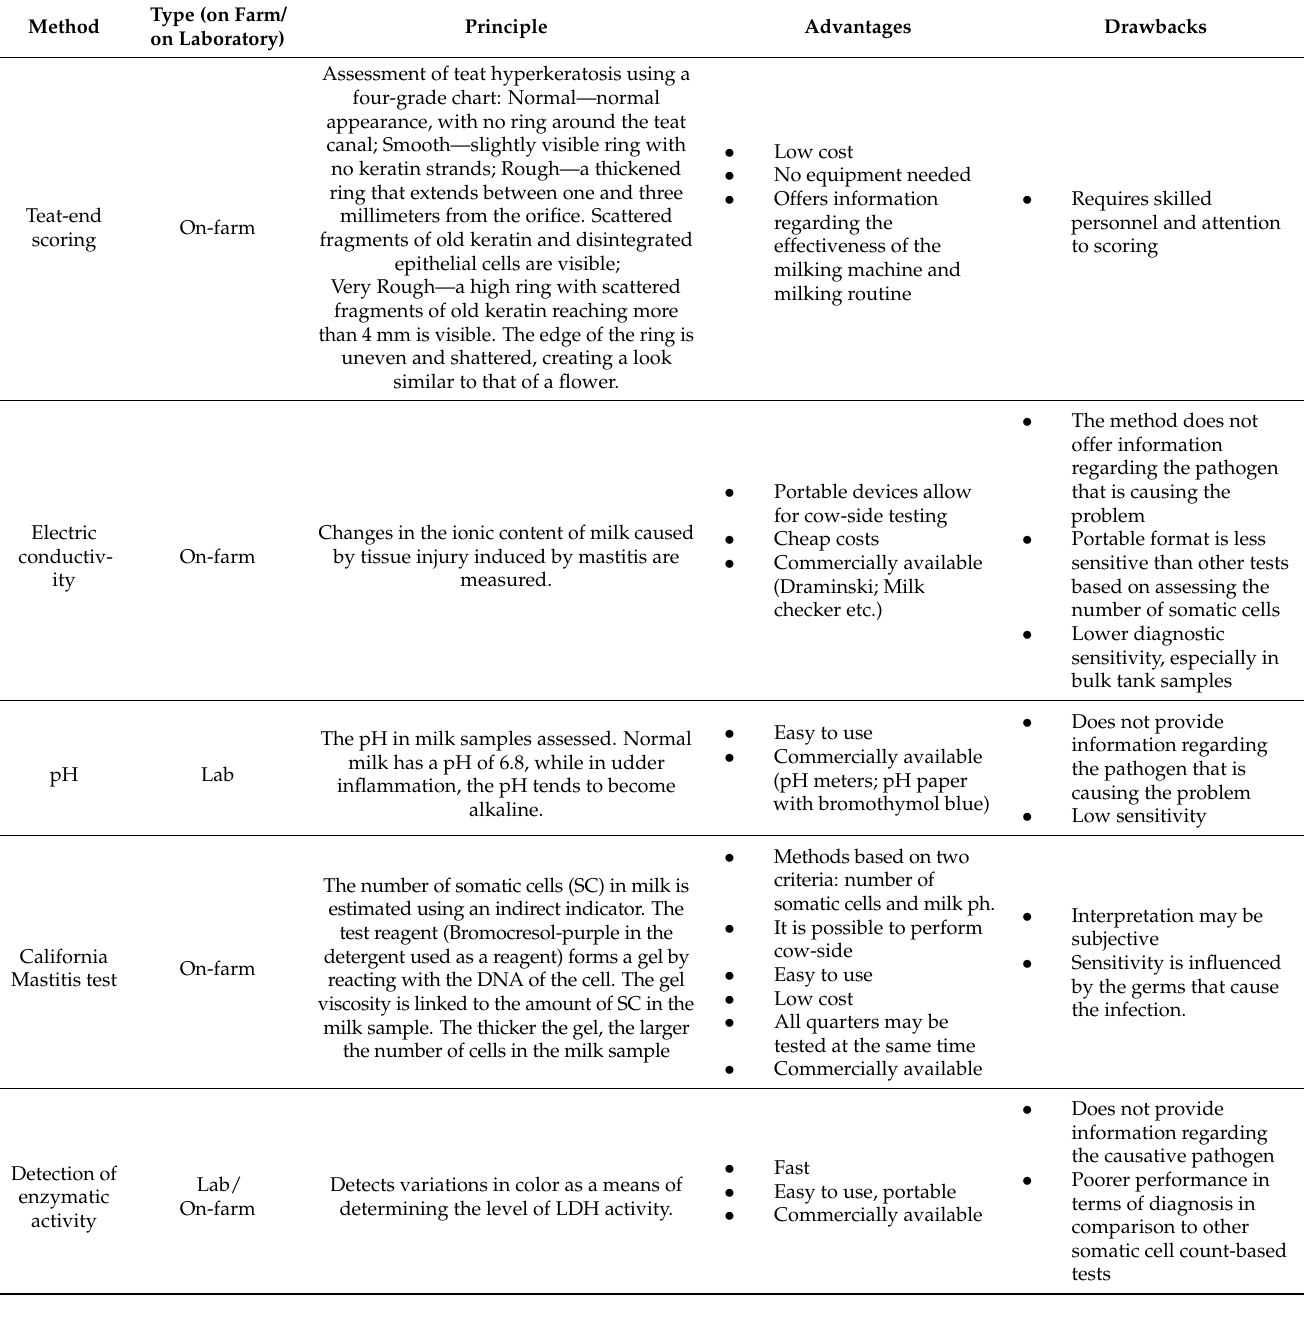
Table 1. Summary of primary conventional methods, based on physicochemical milk modifications, used for monitoring udder